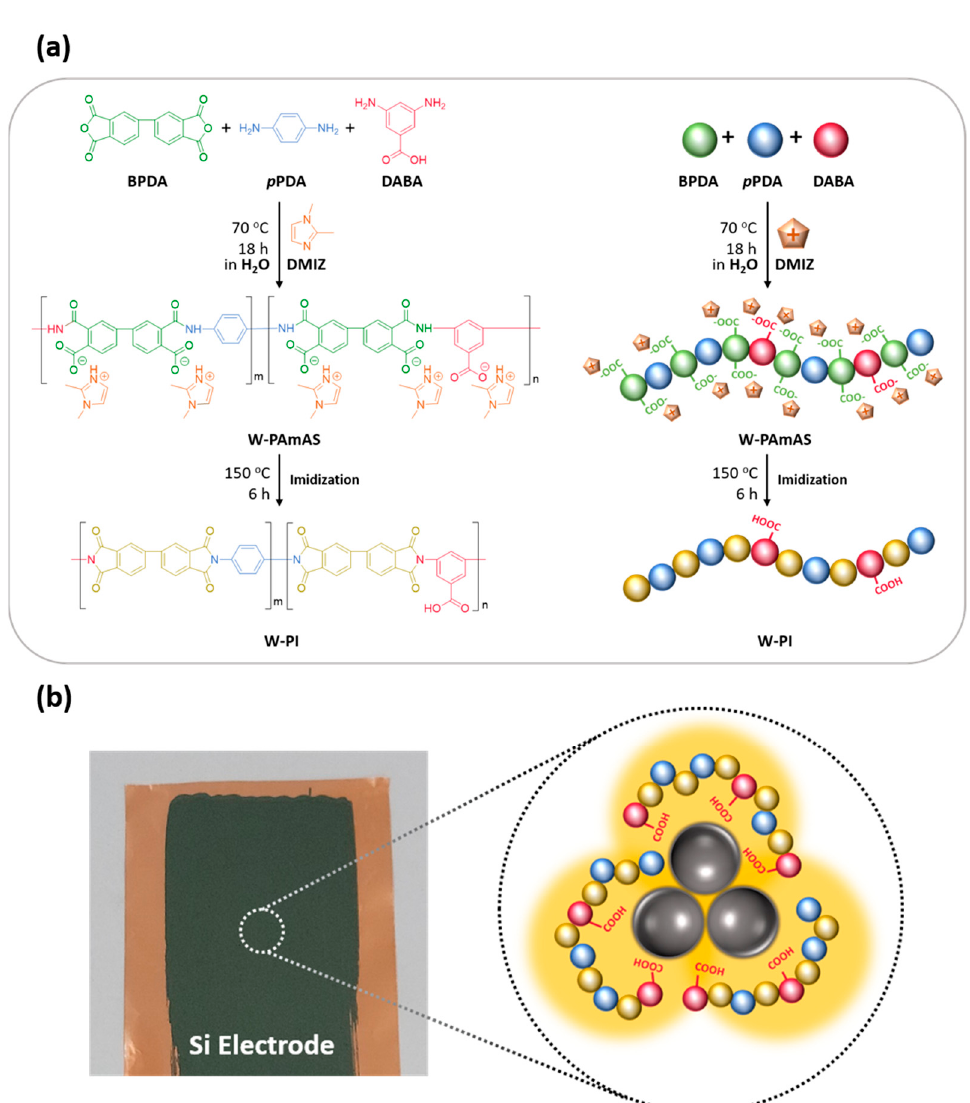
Figure 1. ( a ) Synthesis scheme of W-PAmAS-30 and preparation of W-PI-30. ( b ) Photograph of the Si electrode on Cu foil fabricated using W-PI-30 as a binder after thermal treatment at 150 °C for 6 h and schematic illustration of chemical interactions between SiNPs and the W-PI-30 binder.